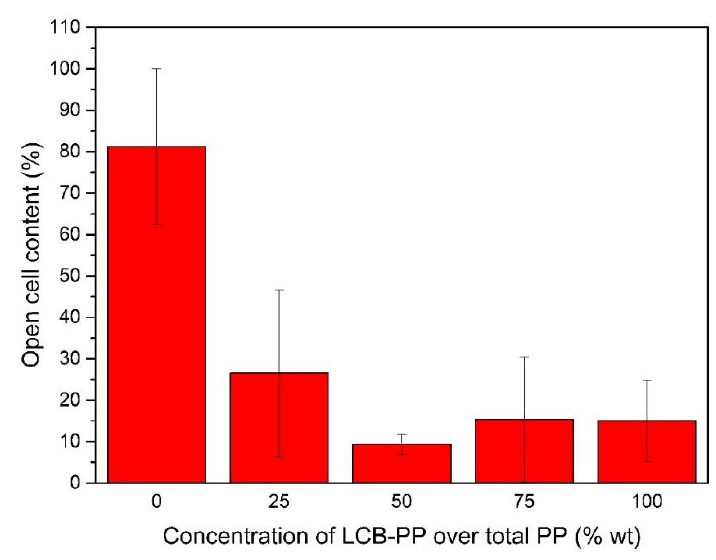
Figure 5. Opel cell content of the foams as a function of LCB-PP content. Table 2. Tensile properties of pure L-PP and LCB-PP thermoformed